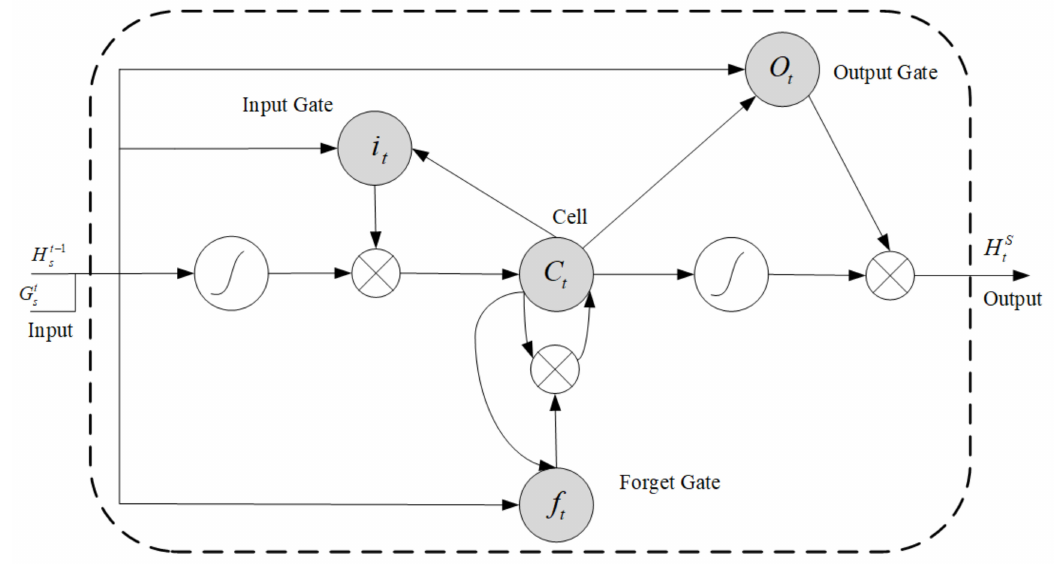
Figure 2. The neuron structure of the LSTM network.